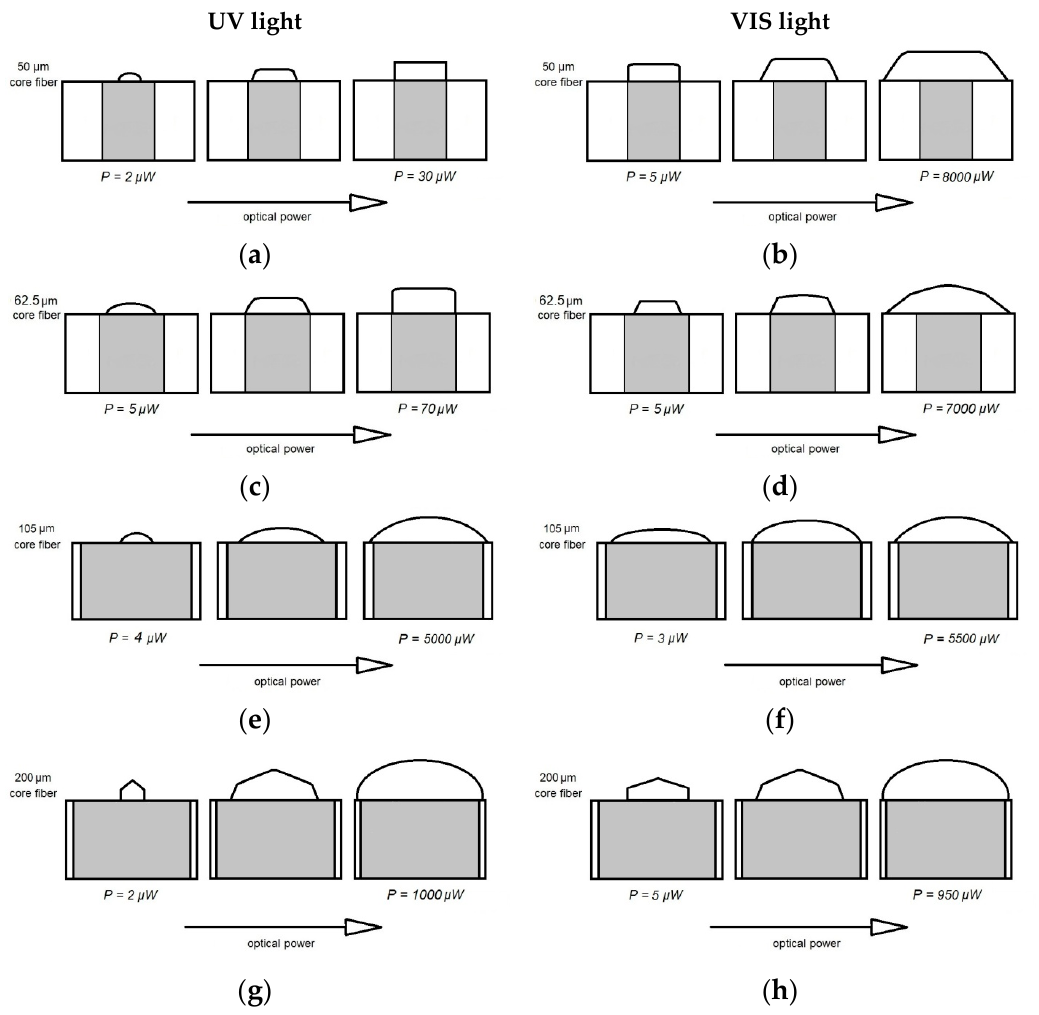
Figure 8. Shapes of microtips’ evolution obtained by using UV light with acetophenone PIS and VIS light with Eosin Y/amine PIS on various optical fibers with a core diameter: ( a , b ) 50 µm; ( c , d ) 62.5 µm; ( e , f ) 105 µm; ( g , h ) 200 µm.